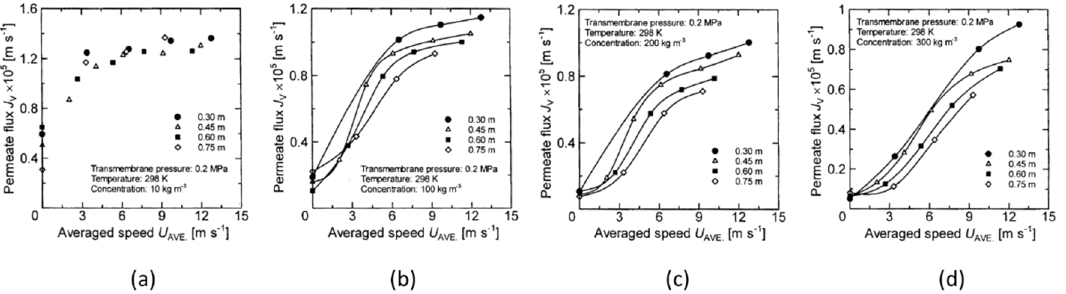
Figure 13. Relationship between average speed and permeate flux when the TMP is 0.3 Mpa. ( a ) at latex concentration 10 kg/m 3 ( b ) 100 kg/m 3 ( c ) 200 kg/m 3 ( d ) 300 kg/m 3 .